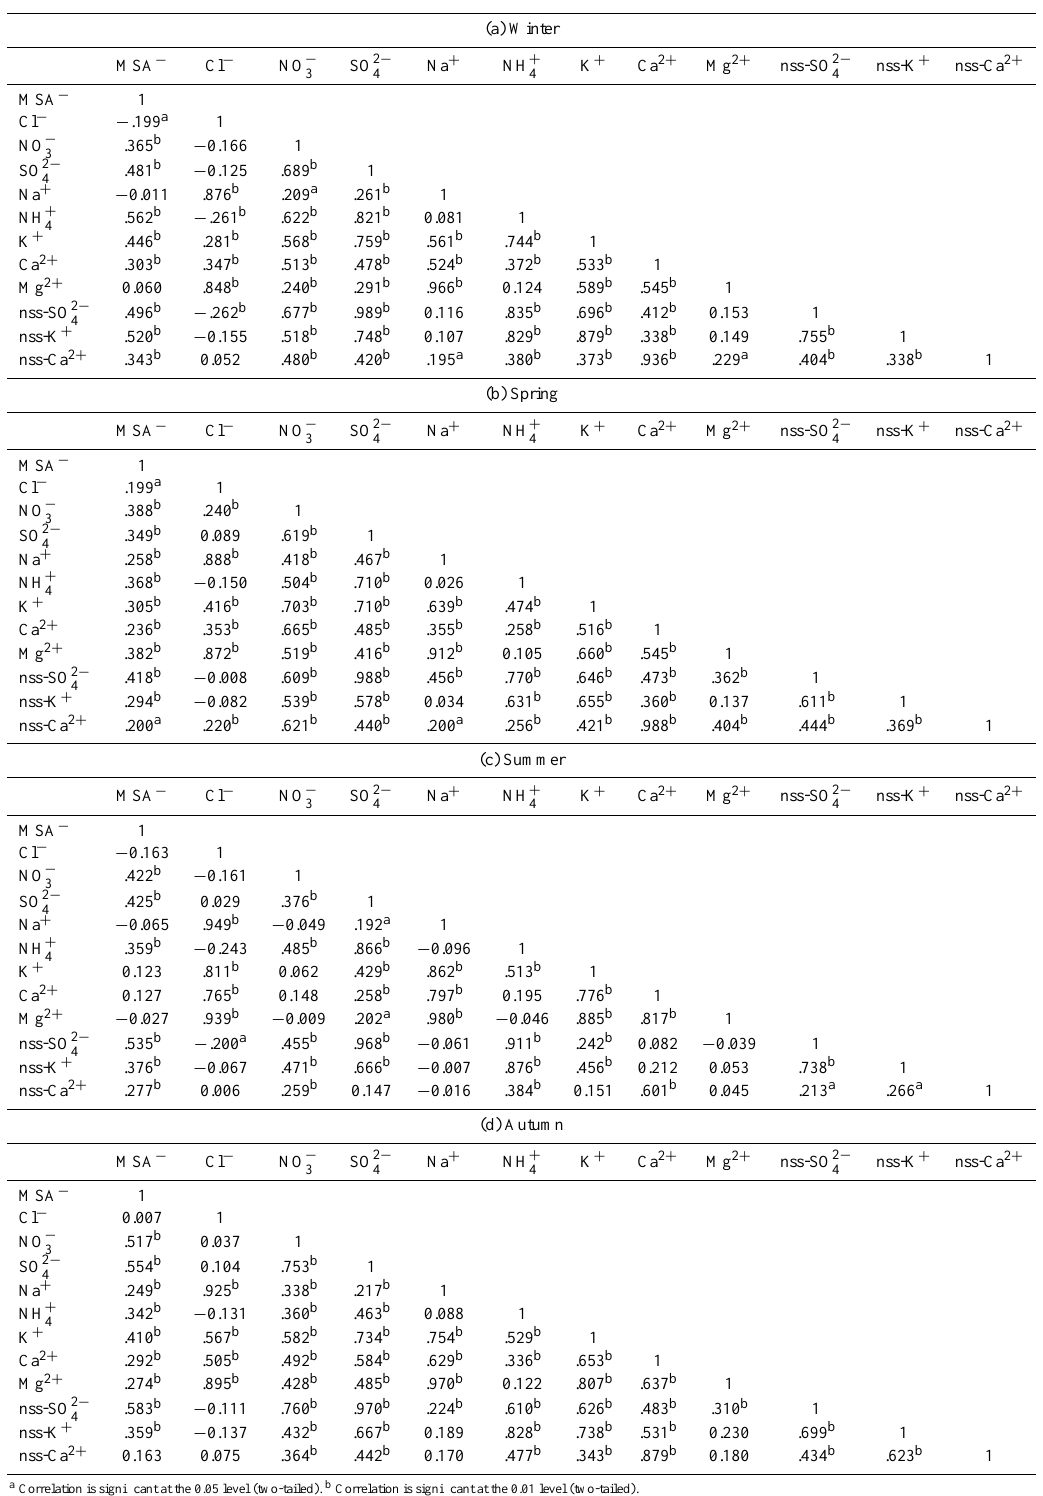
Table 3. Correlation coefficient matrix among the chemical species for (a) winter, (b) spring, (c) summer, and (d) autumn. (a) Winter MSA −